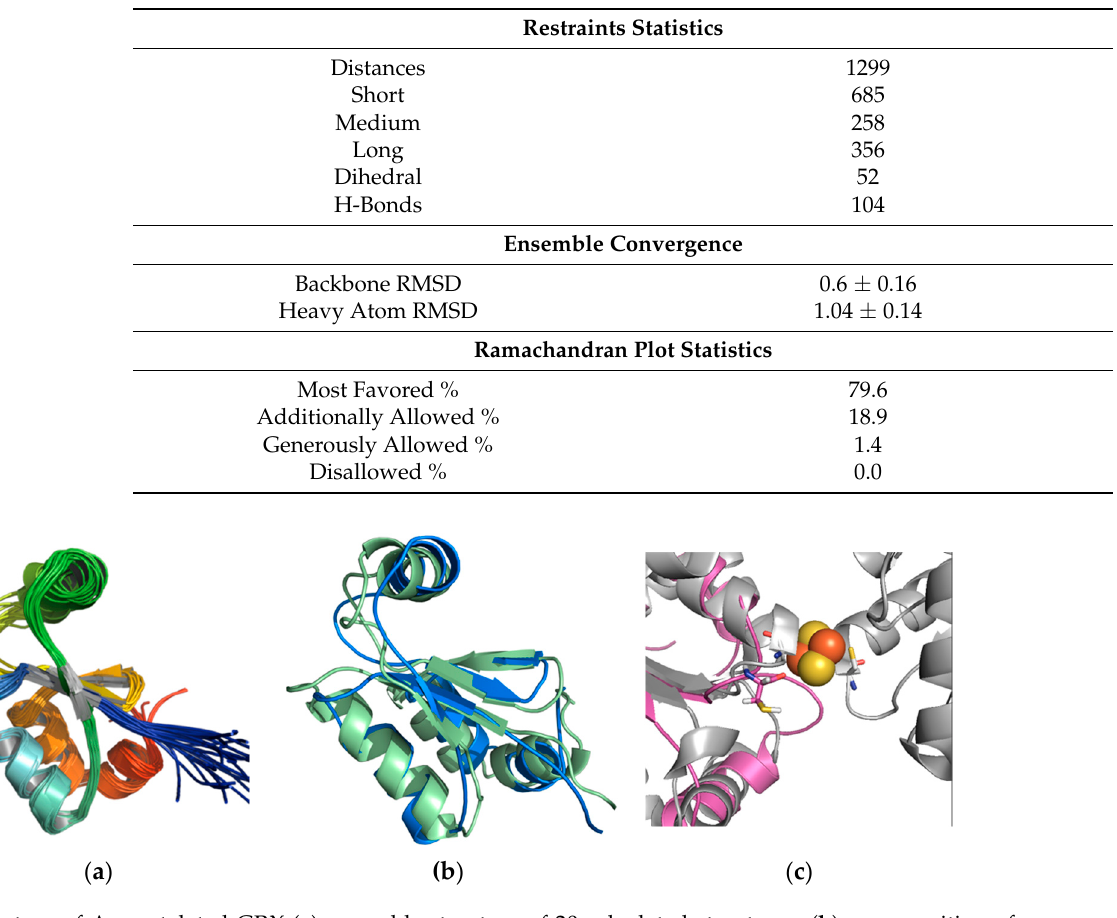
Figure 3. Structure of Ag-metalated GRX ( a ) ensemble structure of 20 calculated structures, ( b ) superposition of apo (green) and Ag-metalated protein (blue) based on an alignment of C-alphas. ( c ) Superposition of Ag-metalated (pink) and iron–sulfur cluster loaded structures (grey).